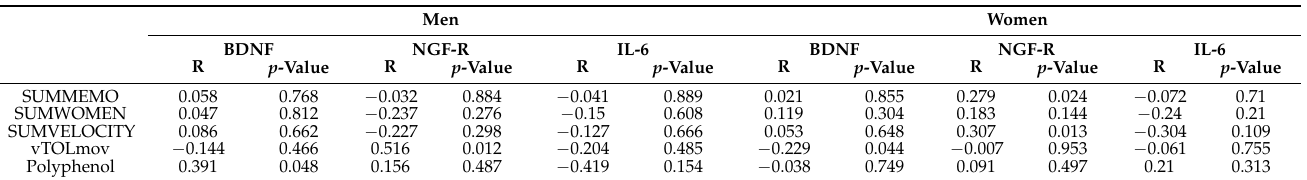
Table 8. Sex-segmented bivariate correlations between biochemical parameters and the sum of cognitive tests and polyphenol